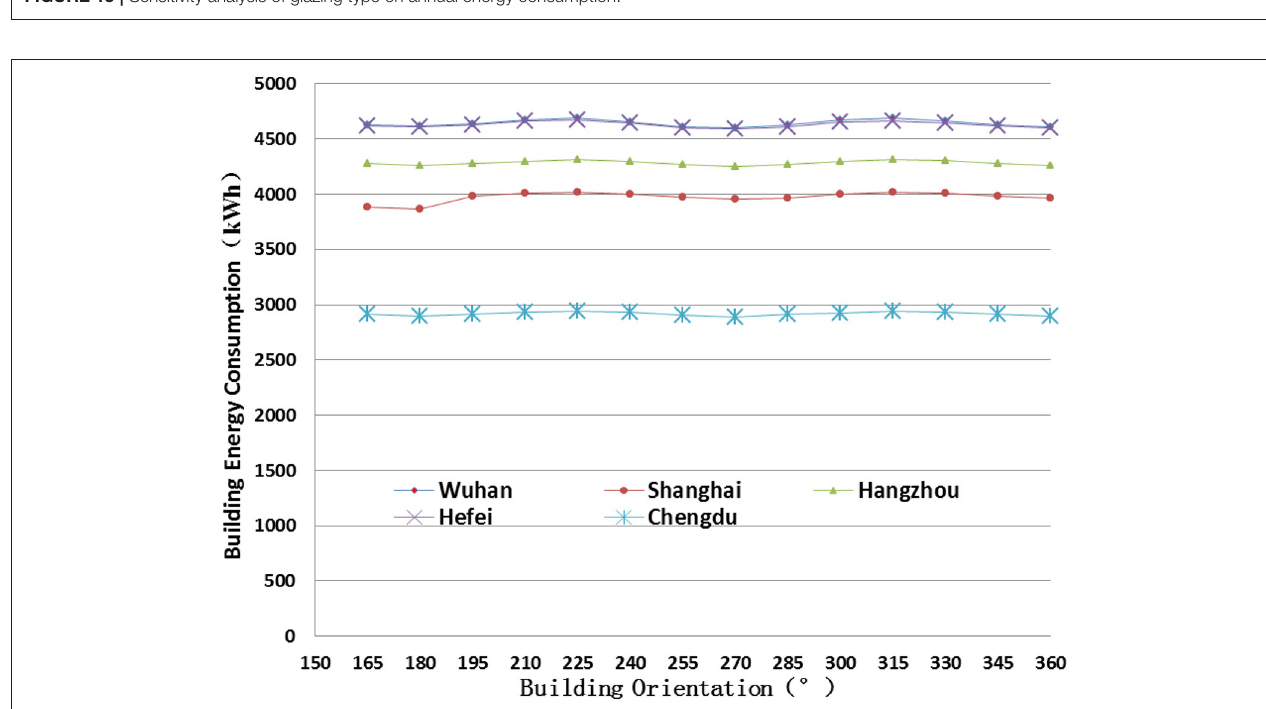
FIGURE 14 | Sensitivity analysis of building orientation on annual energy consumption.